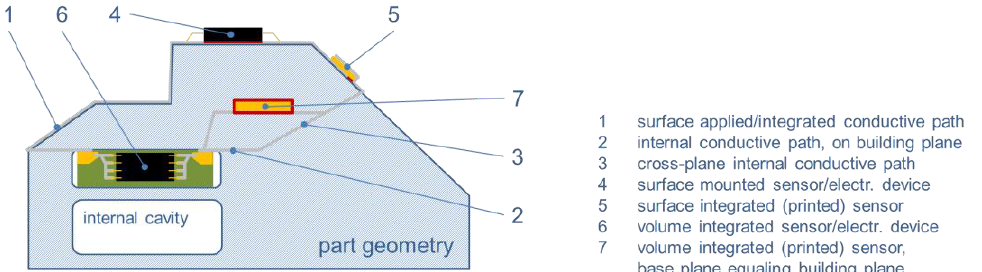
Figure 7. Overview of possibilities for combining sensors and sensor or smart systems with AM parts, inspired by a similar schematic image by Hoerber et al. [84]. The numbering corresponds to categories in Table 2 as follows: No. 1 matches category 1.2, 2 equals 2.2, 3 = 3.1 & 3.3, 4 = 1.1, 5 = 1.2, 6 = 3.1 & 3.3, 7 = 3.3.